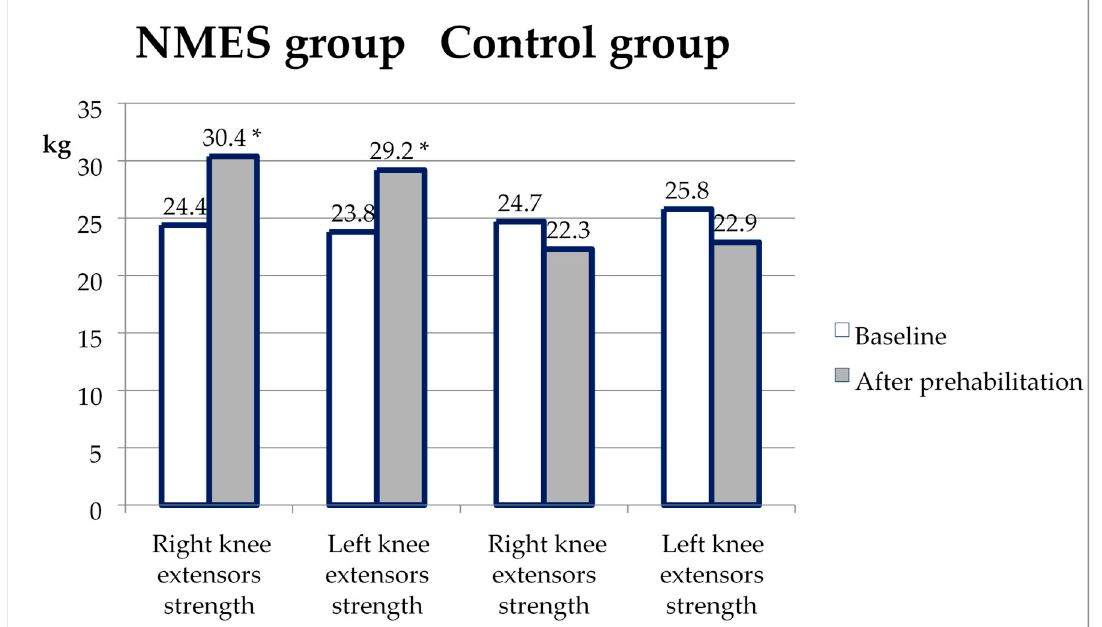
Figure 2. Changes in knee extensor strength from baseline to the second test in the NMES group and control. *— p < 0.05 compared with the control. The maximal knee flexor strength (KFS) increased from baseline to the second test only in the NMES group, not in the control (Table 3). Accordingly, KES in the second test